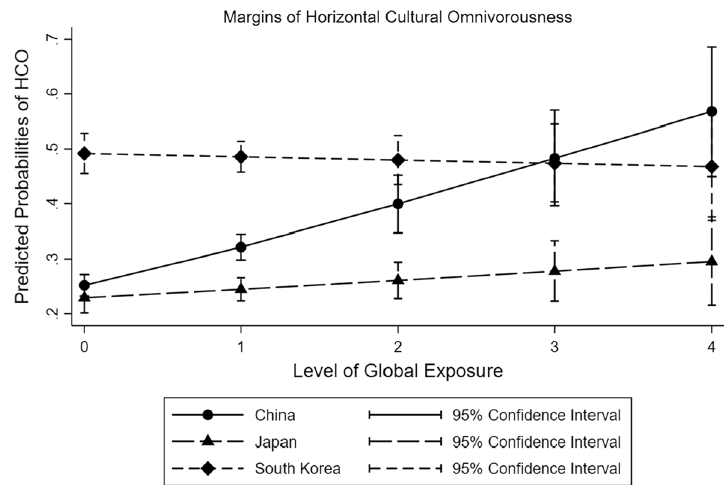
Fig. 3 Predicted correlation between global exposure and horizontal cultural omnivorousness in China, Japan, and South